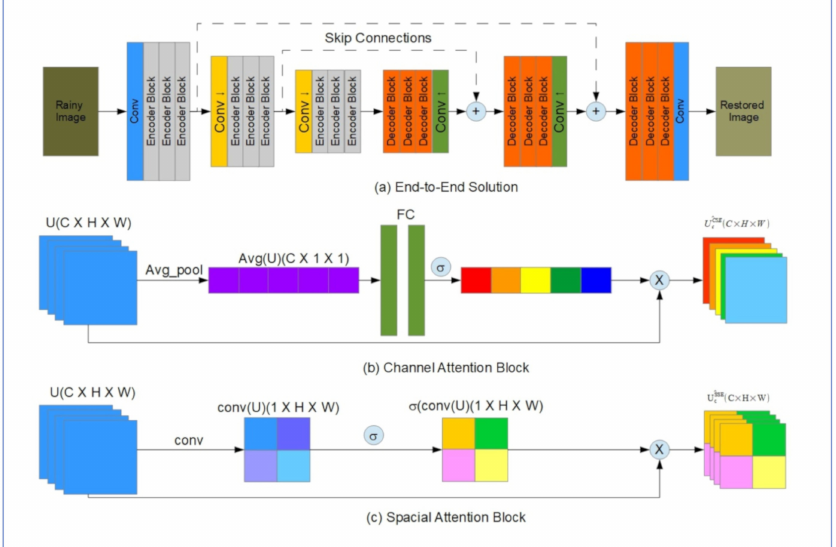
Figure 26. Raindrop removal system with concurrent spatial and channel attention, as proposed by Peng et al.